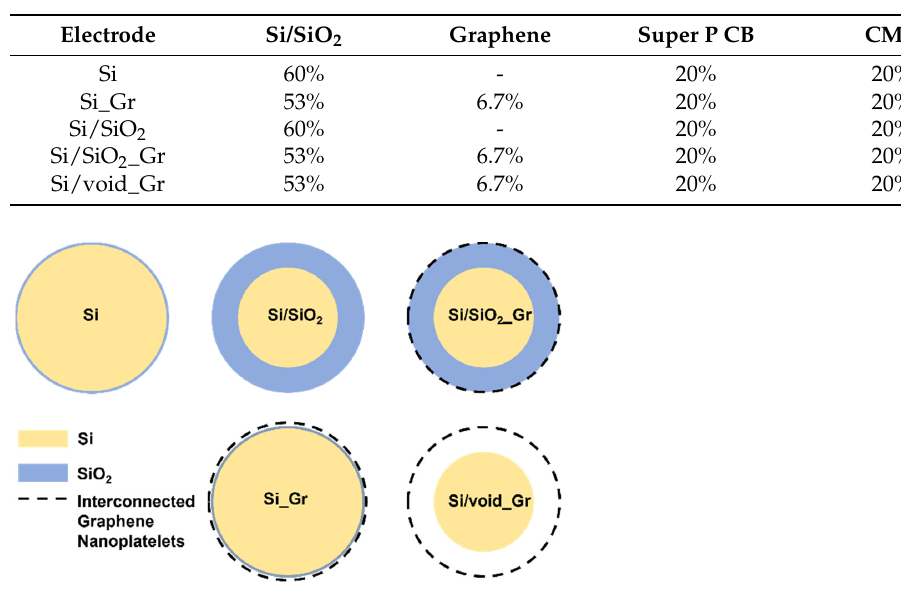
Figure 1. Graphical representation of various prepared nanoparticles in the corresponding electrodes. Dimensions are not in scale. Dimensions are not in